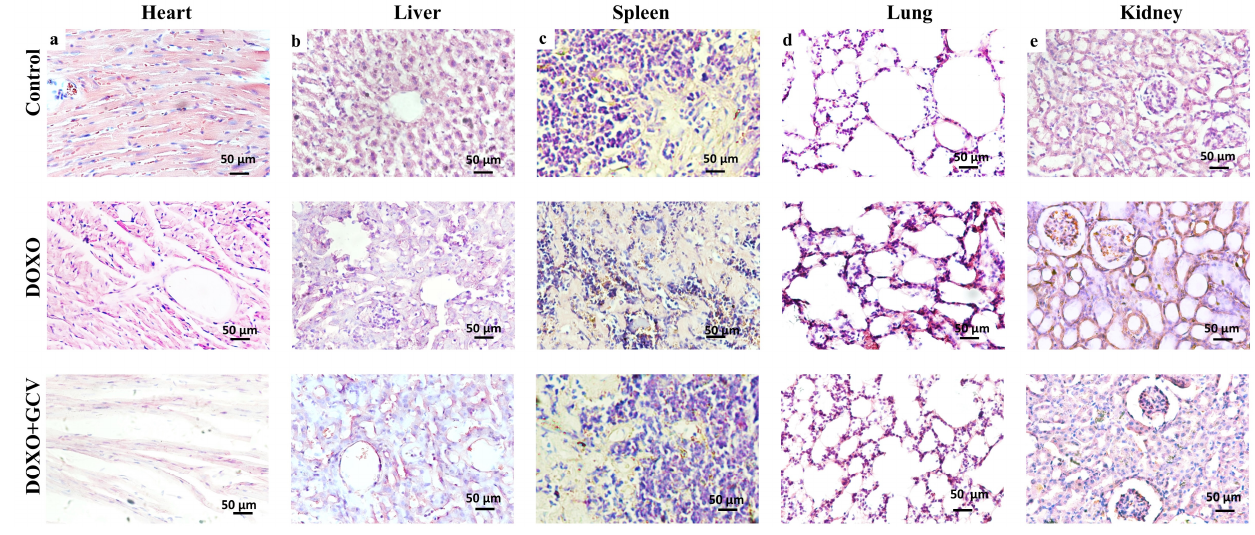
Figure 4. Histological changes in vital organs following GCV administration. ( a – e ) Representative HE staining of 5 vital organs in p21 ‐ 3MR mice from control/DOXO, and DOXO+GCV